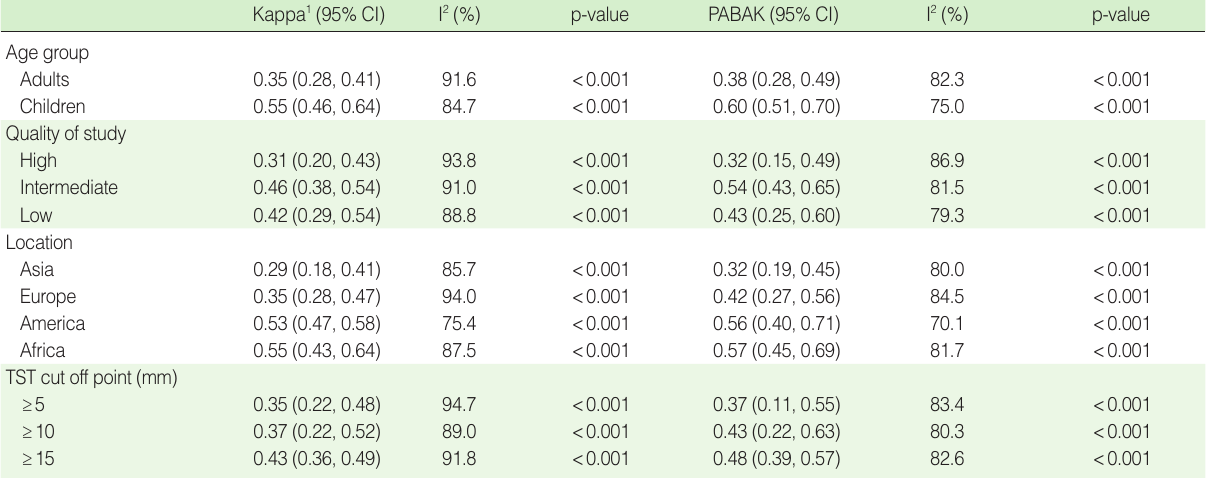
Table 2. Subgroup analysis of kappa and PABAK by quality of study and location (continent) using the chi-squared test for heterogeneity